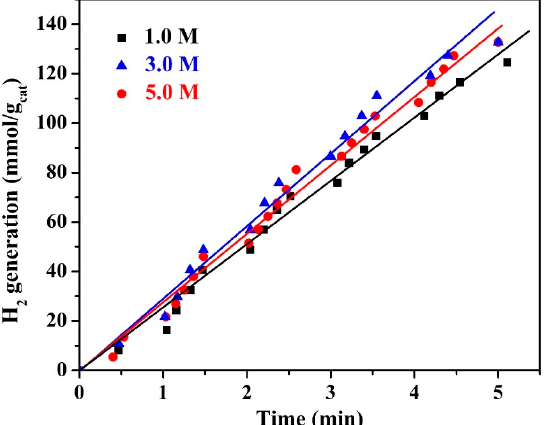
Figure 11. The influence of the KOH solution concentration on the hydrogen production rate from water splitting under visible light radiation; hydrothermal duration of 6 h, temperature of 150 °C, and calcination temperature of 800